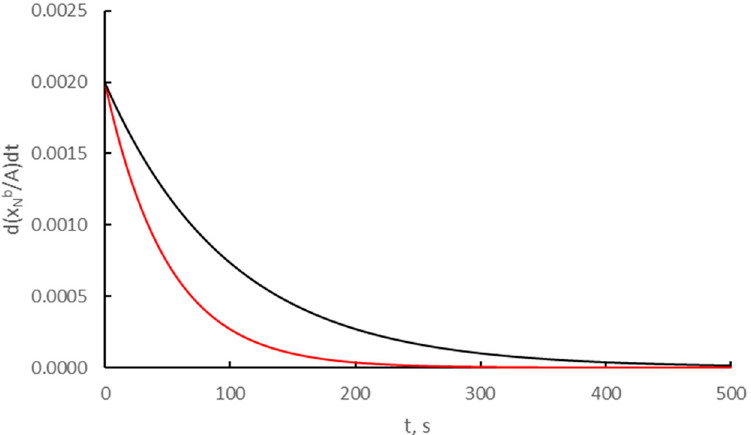
Figure 5. Process rates on two different crystallites with a specific active surface area 0.15 nm − 1 (black color) and 0.04 nm − 1 (red color) as d